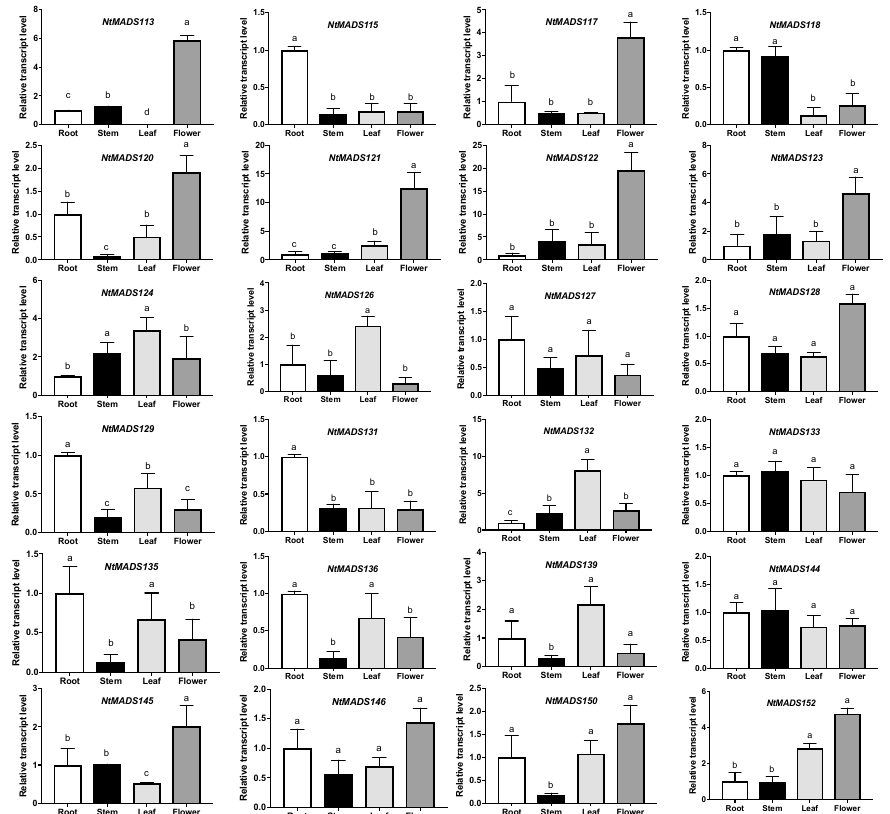
Figure 6. Expression profiles of 24 selected NtMADS-box genes in tobacco. The relative transcript abundances of 24 selected NtMADS-box genes were examined via qPCR and visualized as a histogram. The tobacco flowers (120 day old plants) and 6–7 week old seedlings grown in the soil were